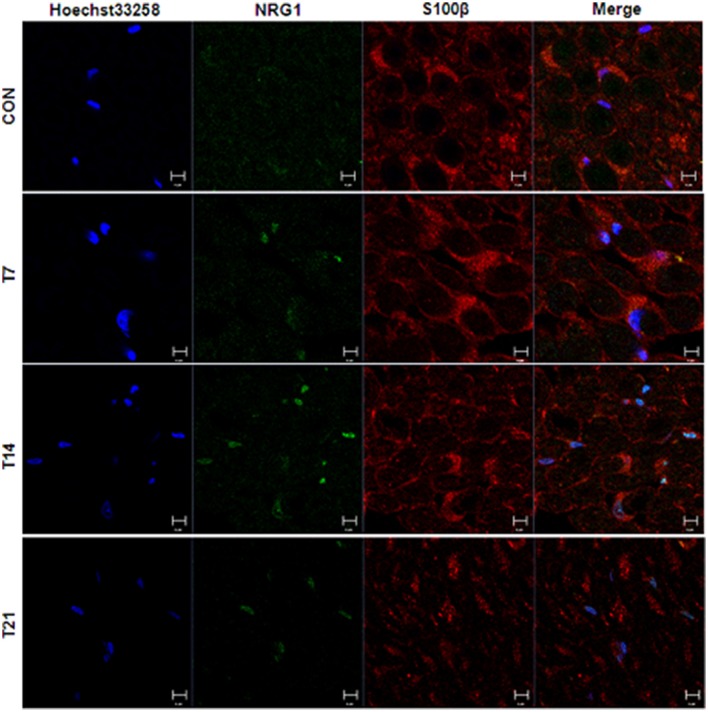
Immunofluorescence staining of neuregulin 1 and Schwann cell specific S100β in sciatic nerve of hens treated with TOCP. Adult hens were administrated with TOCP (750 mg/kg body weight, po), and then the sciatic nerve samples were collected on days 7, 14, and 21. Anti-neuregulin 1 (sc-348) (green) and anti-S-100 β chain (sc-28533) (red) were used to detect neuregulin 1 and label Schwann cells, respectively. Hoechst 33258 (blue) was used to mark nucleus. The histogram in lower panel was the quantitative result of the immunofluorescent staining. CON, control; T plus number indicated the sampling time (days) after TOCP treatment. Scale bar: 5 μm.